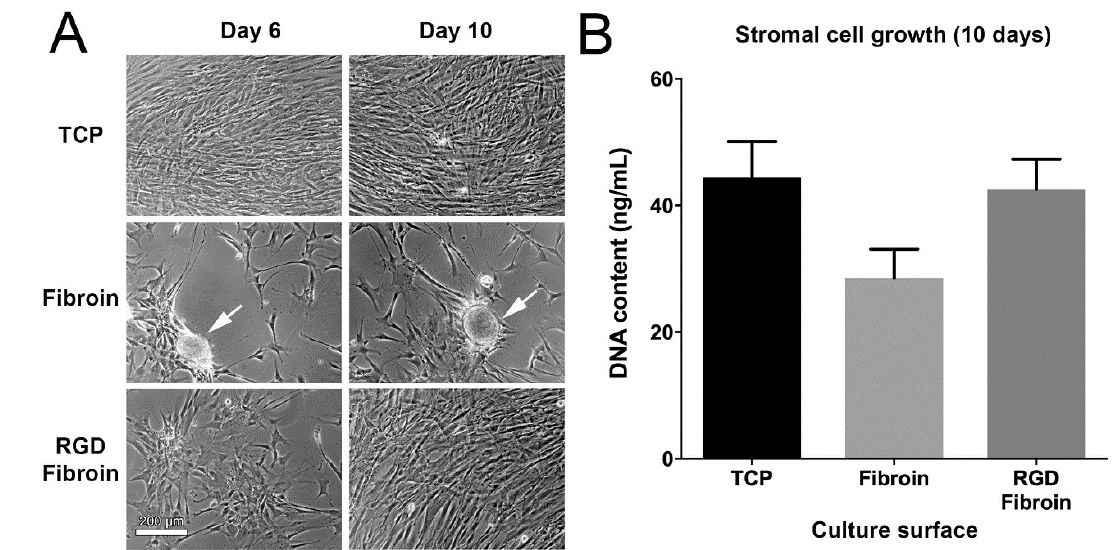
Figure 3. ( A ) Visual comparison of limbal stromal cell growth behaviour in the presence of serum (10% v / v FBS) on TCP, TCP coated with Fibroin (BMSF), or TCP coated with RGD-Fibroin. Cells were seeded at a density of 15,000 cells/cm² in 24-well culture plates and photographed after 6 and 10 days, respectively. White arrows indicate the presence of cell clumps that became more apparent in cultures established on Fibroin-coated TCP. ( B ) Quantification of stromal cell growth after 10 days using PicoGreen assay. Bars represent data obtained using stromal cell cultures established from 4 unique donors. Despite clumping, no significant differences in cell numbers (as measured by dsDNA content) were observed after 10 days (Friedman test with Dunn’s multiple comparisons test).